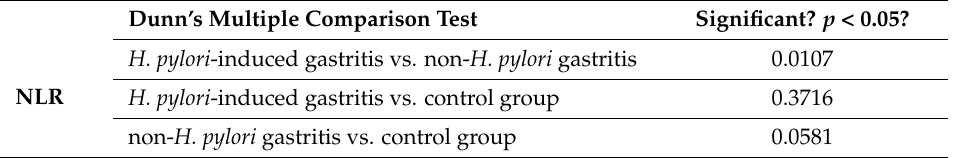
Table 3. The difference of median values of NLR between the three